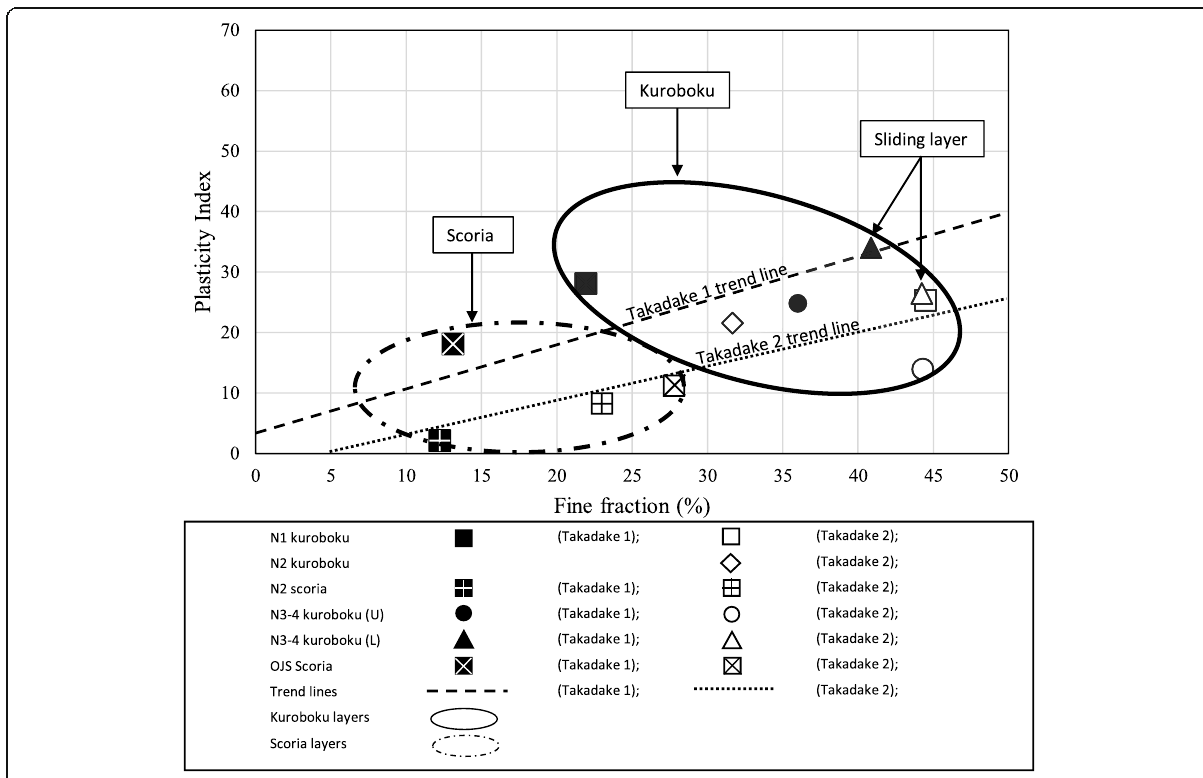
Fig. 7 Correlation between fine fraction content (%)-plasticity index shows dissimilarity between kuroboku and